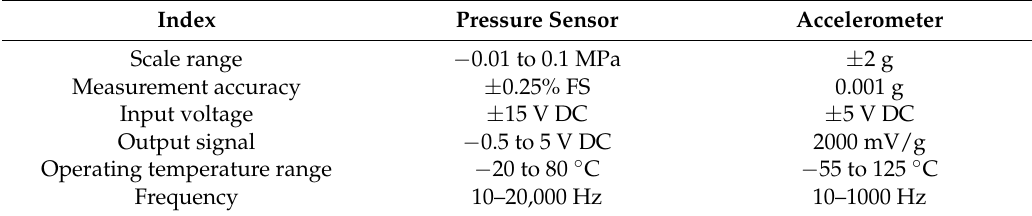
Table 2. Technique data of the pressure sensor and accelerometer.